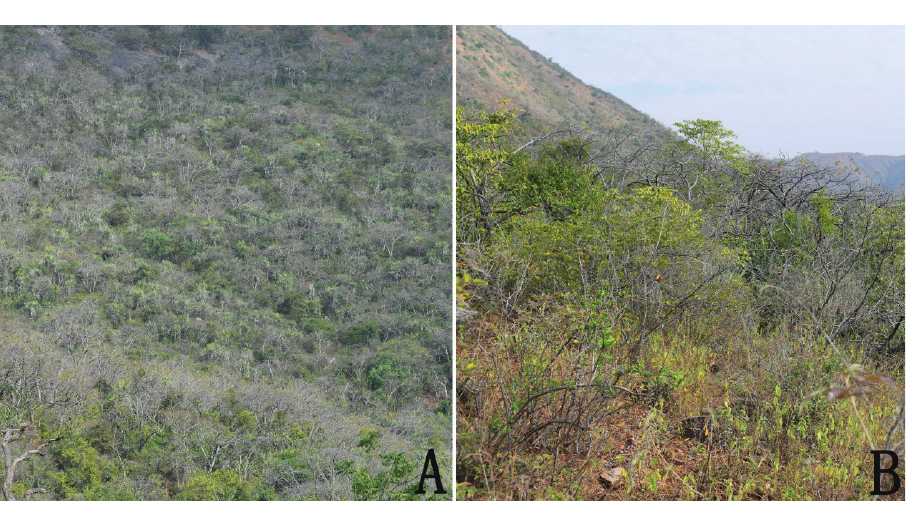
Figure 5. Habitat of Breynia hiemalis A distant view of the type locality B nearby view.